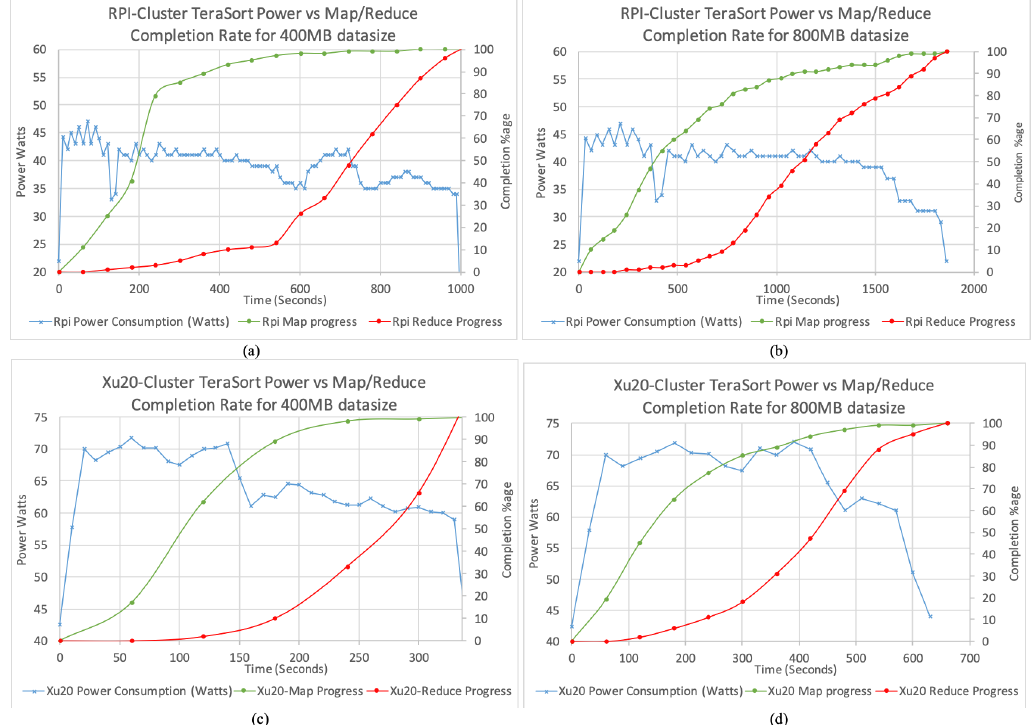
Figure 7. TeraSort Power consumption for: ( a ) RPi Cluster with 400 MB data size; ( b ) RPi Cluster with 800 MB data size; ( c ) Xu20 Cluster with 400 MB datasize; and ( d ) Xu20 Cluster with 800 MB data size. In all plots, the secondary axis shows completion of map and reduce jobs in